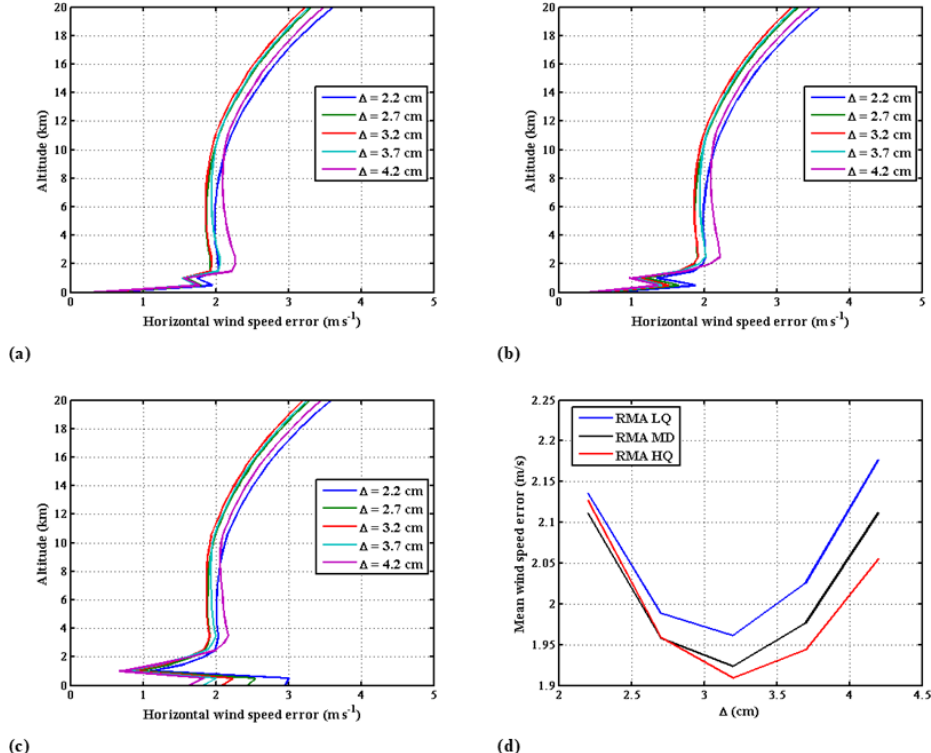
Figure 6. (a, b, c) Horizontal wind speed (HLOS) statistical error as a function of altitude for OPD for lower quartile, median, and higher quartile RMA aerosols distribution, respectively. (d) Wind speed error averaged between 0.5 and 15km in altitude as a function of OPD. Table 3. HLOS wind statistical error of the proposed QMZ design compared to the original Aeolus requirements.